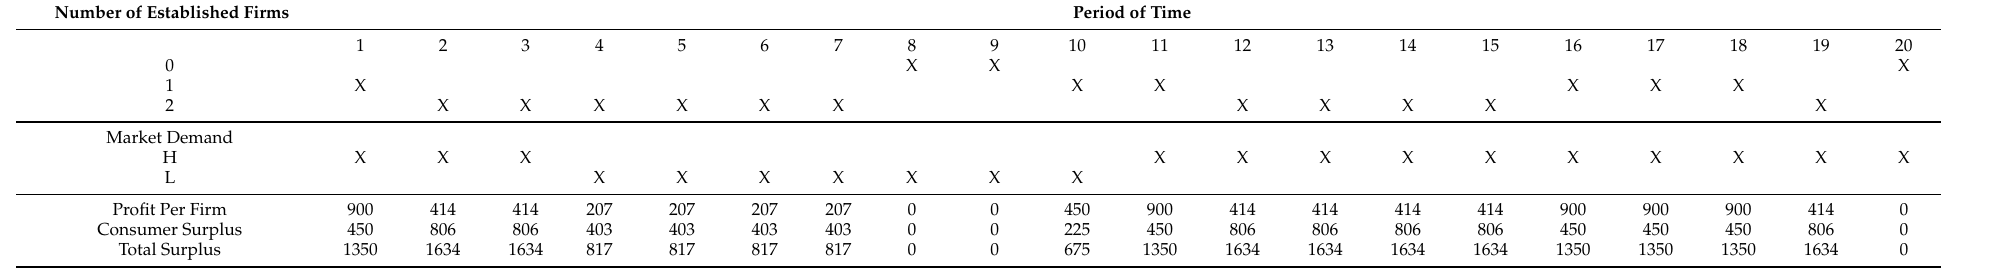
Table 8. Two active firms in the Cournot framework with the initial state of the system ( 1, H ) .